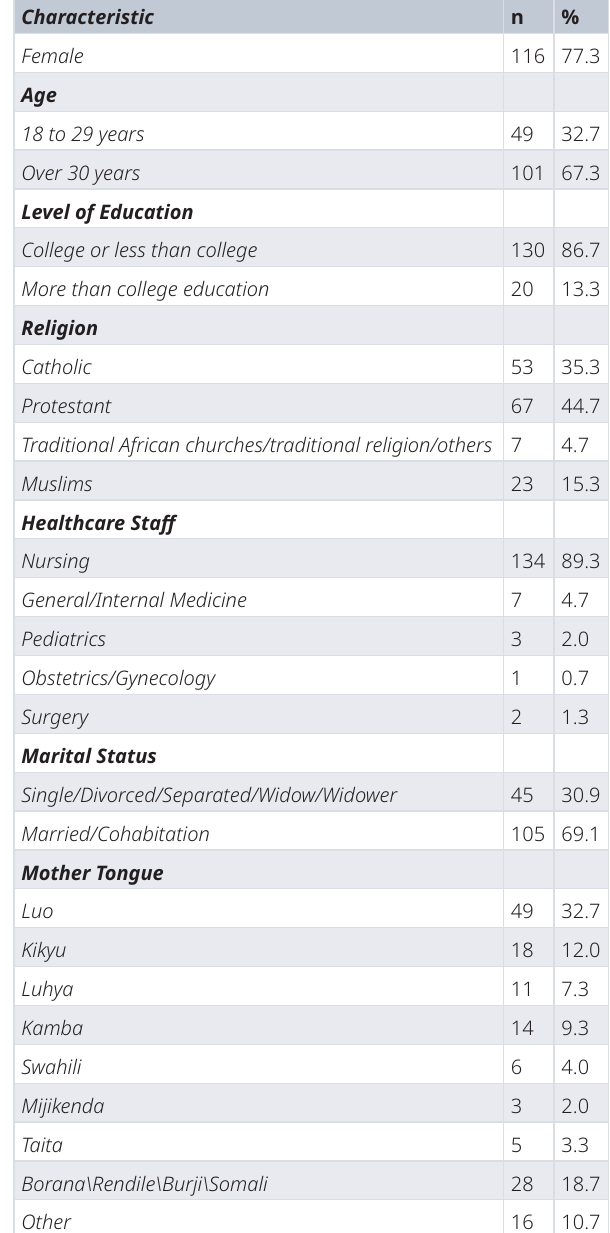
Table 1. Demographic information and characteristics of antenatal care (ANC) provider.